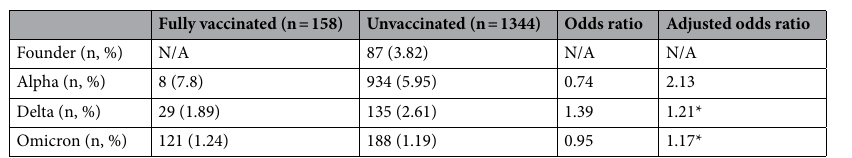
Table 9. Comparison of mortality rate and mortality odds ratio by variants between fully vaccinated and unvaccinated individuals. p -value < 0.05 is significant, *denotes p -value < 0.05.